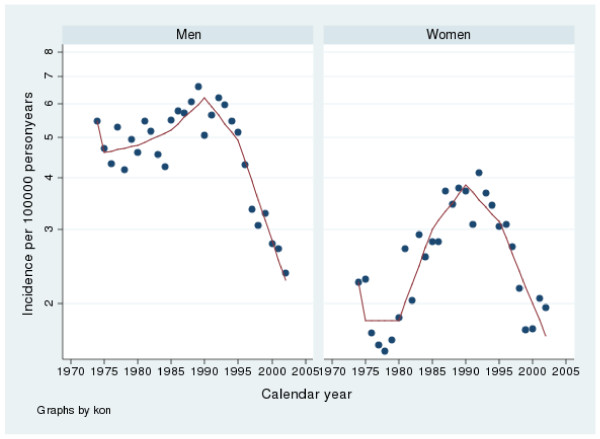
Incidence of duodenal perforated peptic ulcers in Sweden from 1974 to 2002. Note that the y-axis has been truncated.